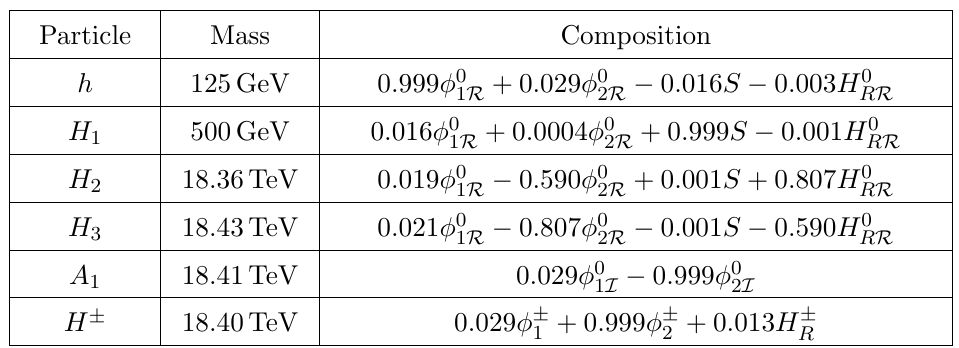
Table 1 . Scalar mass eigenstates for (cid:21) 1 = 0.146, (cid:21) 2 = 0.35, (cid:21) 3 = 0.831, (cid:21) 4 = 0.01, (cid:11) 3 = 0.14, (cid:11) 4 = 0.1, (cid:11) 5 = 0.1, (cid:22) 3 = 174 GeV, (cid:22) 4 = 174 GeV, (cid:12) 1 = 0.1, (cid:12) 2 = 0.1, (cid:12) 3 = 0.004, (cid:26) 1 = 0.2, (cid:26) 2 = 0.2, (cid:26) 3 = 2, (cid:22) 2 = (655) 2 GeV 2 , v 1 = 173.9 GeV, v 2 = 5 GeV, v R = 13 TeV. Subscript R and I stands S for the real and imaginary parts of the (cid:12)eld